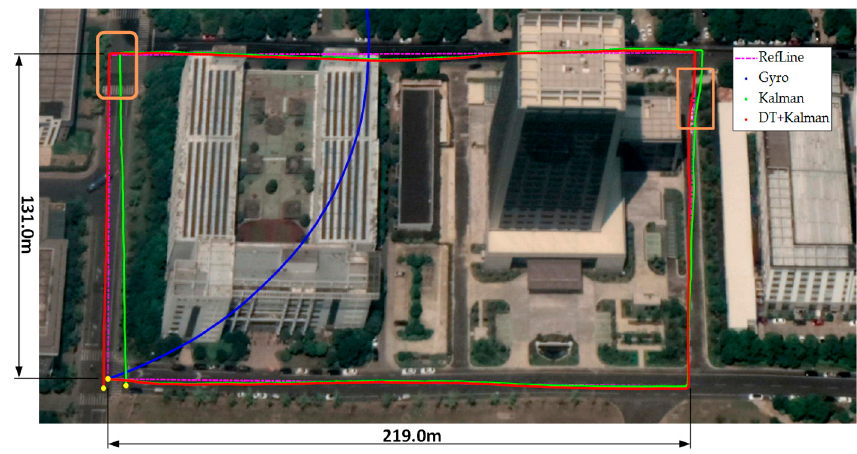
Figure 12. Trajectory test of the three different algorithms for outdoor pedestrian inertial navigation. The walking time is 598.6 s outdoors.